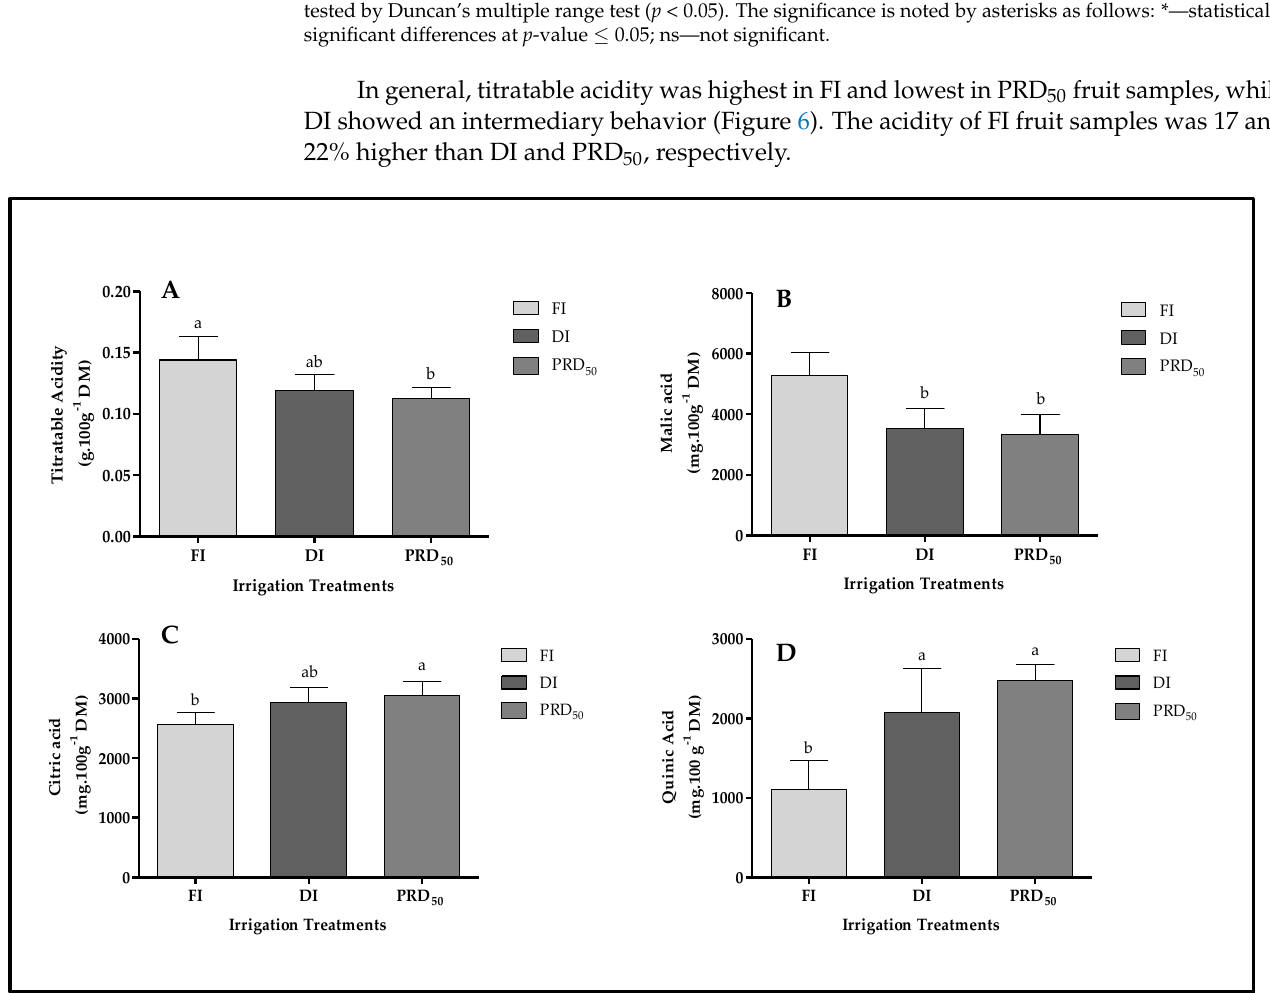
acid and quinic acid content (Figure